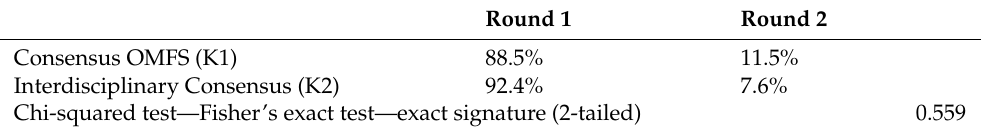
Table 7. Number of rounds.